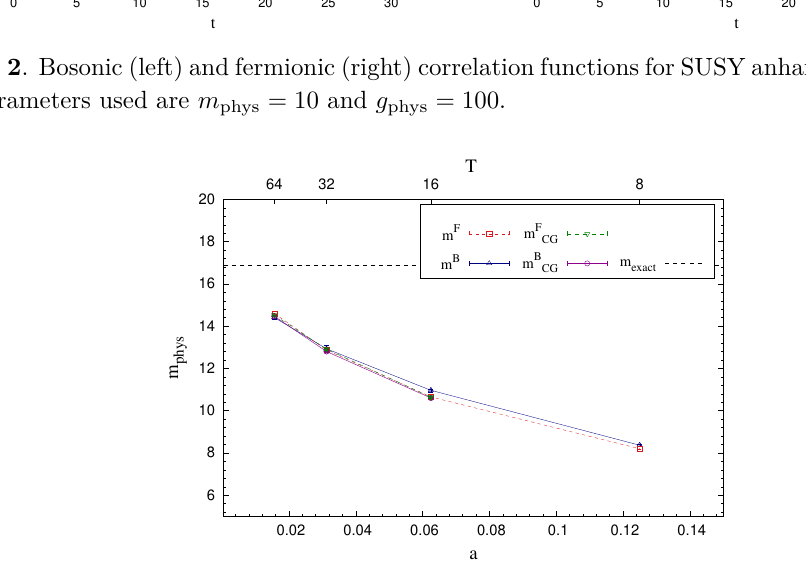
Figure 3 . Bosonic and fermionic mass gaps for SUSY anharmonic oscillator. The parameters used are m phys = 10 and g phys = 100 . Here m B mass-gap results from ref.